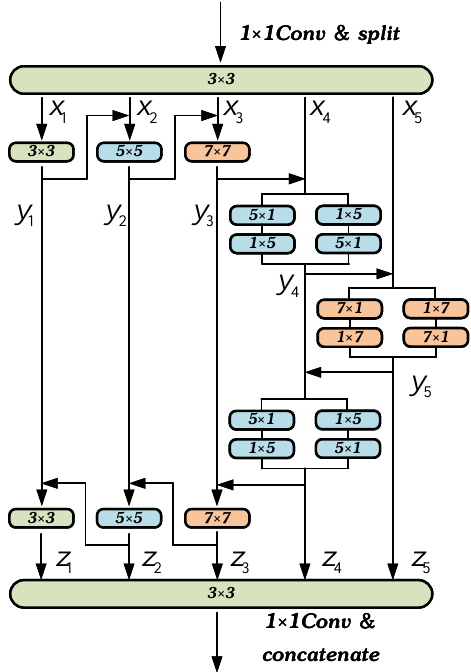
Figure 5. The structure of